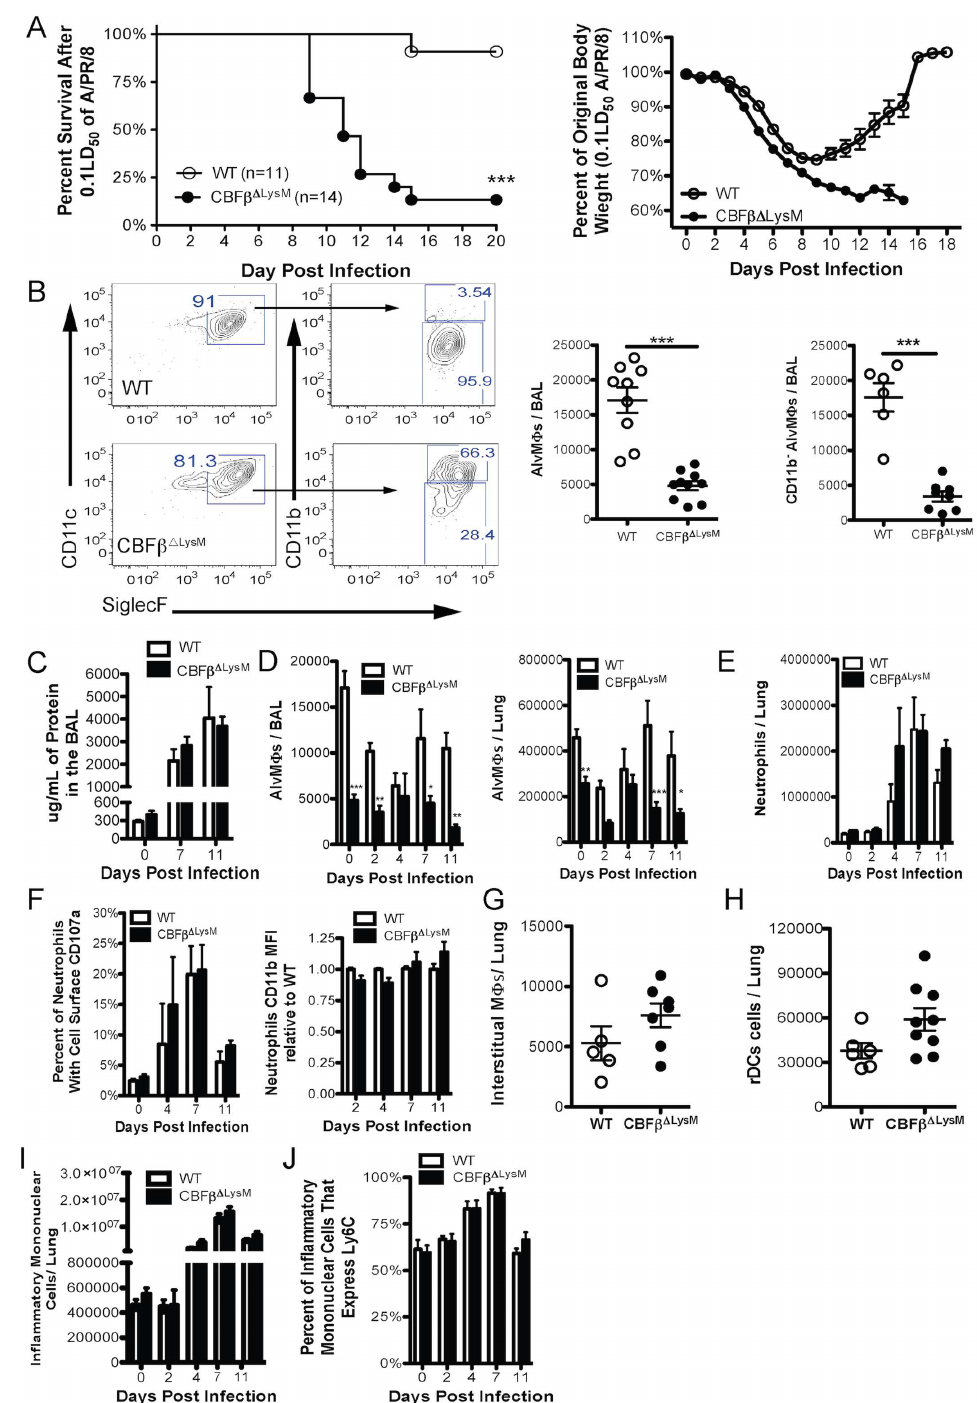
Fig 1. Alveolar macrophage deficient CBF β Δ LysM mice exhibit enhanced mortality after influenza infection. WT and CBF β Δ LysM mice were infected i.n. with a 0.1LD50of A/PR/8. a) Survival(left) and weight loss (right) (with survivingCBF β Δ LysM mice removed)out to day 20 PI. b) Representative flow plots and total numbers of AlvM Φ s(left) and CD11b - AlvM Φ s(right) in the BAL fluid at day 0 PI. c) Total protein detected in the BAL at the indicateddays PI. d) Total numberof AlvM Φ sin the BAL and lungs at the indicateddays PI. e) Total numberof neutrophilsin the lung and their f) percent with cell surface CD107a(first panel)and CD11b MFI (secondpanel)at the indicateddays PI. g) Total numbersof lung interstitial macrophages and h)